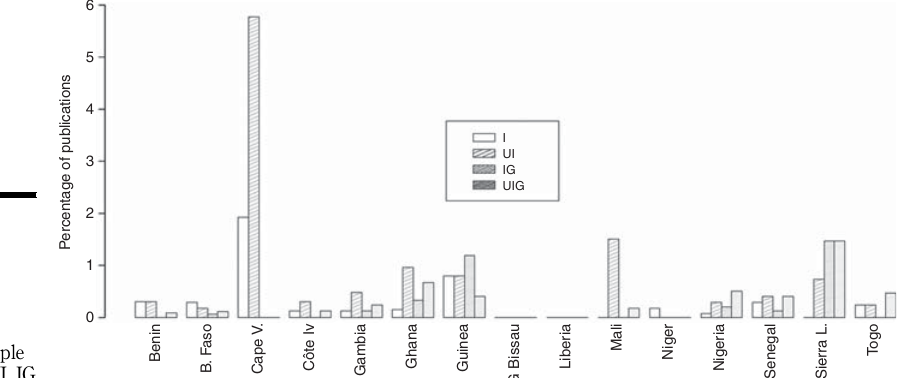
Figure 3. Outputs of the Triple Helix spheres (I, UI, IG and UIG) in selected innovation systems